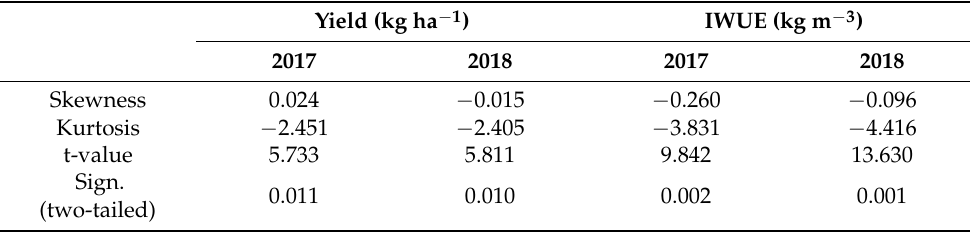
Table 7. Normality test and t -test for difference in grain yield (kg ha − 1 ) and water use efficiency (IWUE) (kg m − 3 ) among the four irrigation treatments for 2017 and 2018. Yield (kg ha − 1 ) IWUE (kg m − 3 )